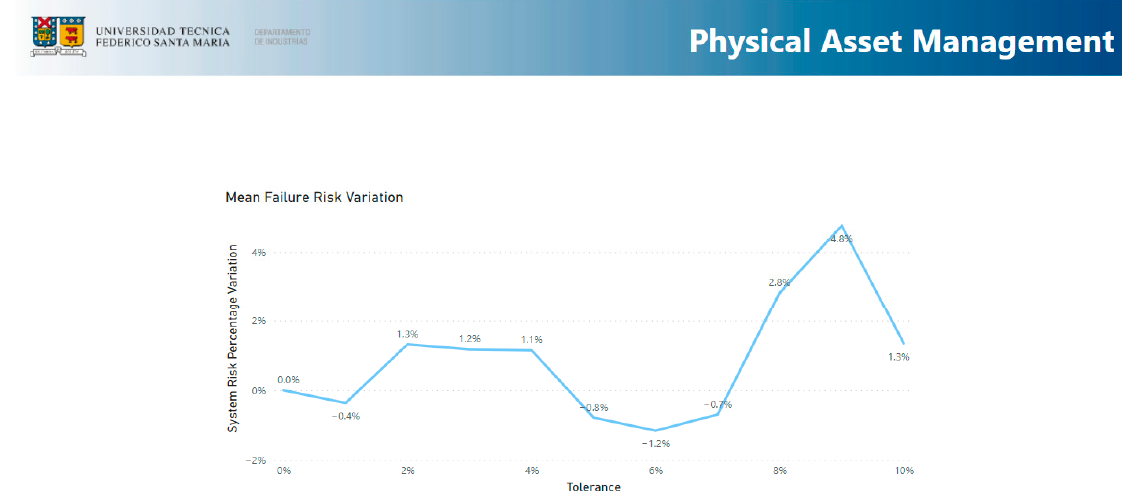
Figure 5. Physical asset management section.